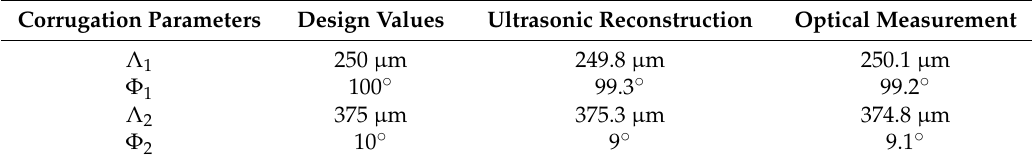
Figure 12. Microscopic image of ablated 2D subsurface corrugation ( a ) and corresponding H-UBPS recording at f = 5 MHz ( b ). Table 1. Corrugation parameters: design (column 1), ultrasonic reconstruction (column 2) and optical measurement (column